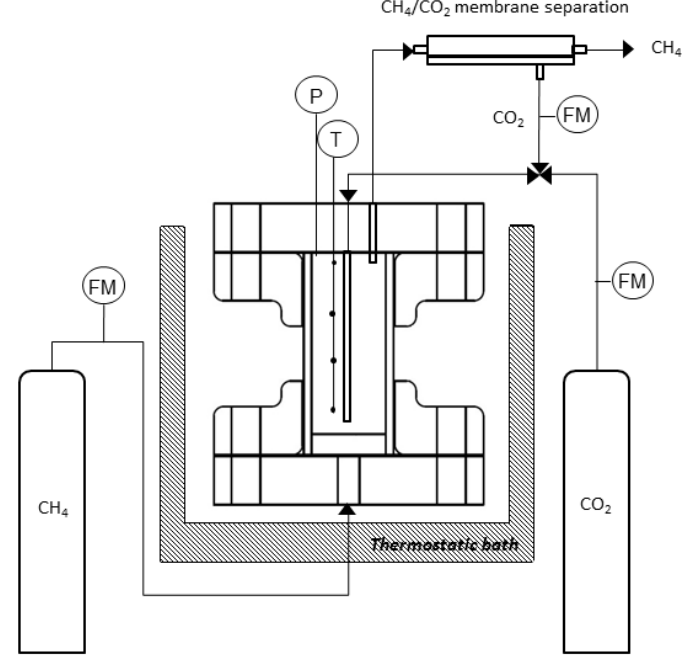
Figure 4. Schematic drawing of the membrane-based replacement process.